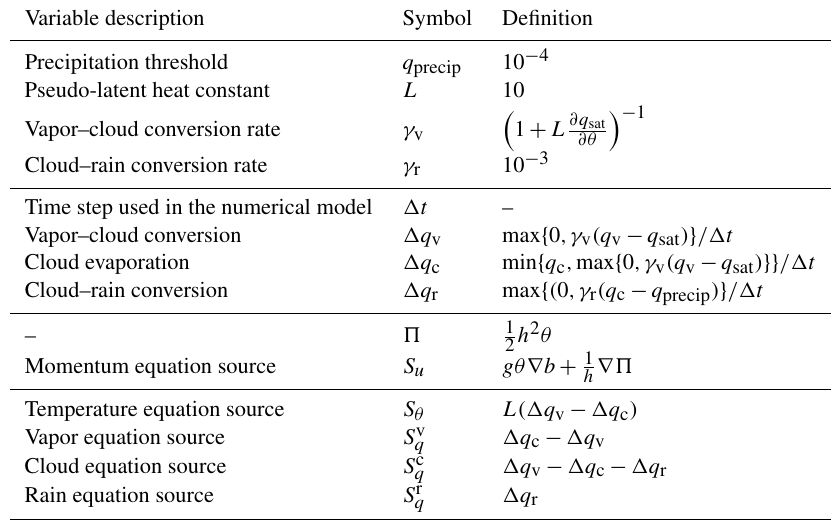
Table 4. Variables and parameters for the moist shallow-water model (Zerroukat and Allen,